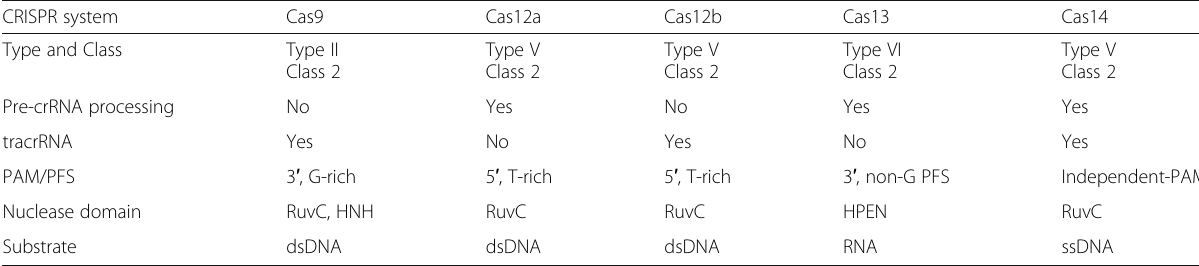
Table 1 Characteristics of different types of CRISPR/Cas systems involved in plant-pathogen interactions CRISPR system